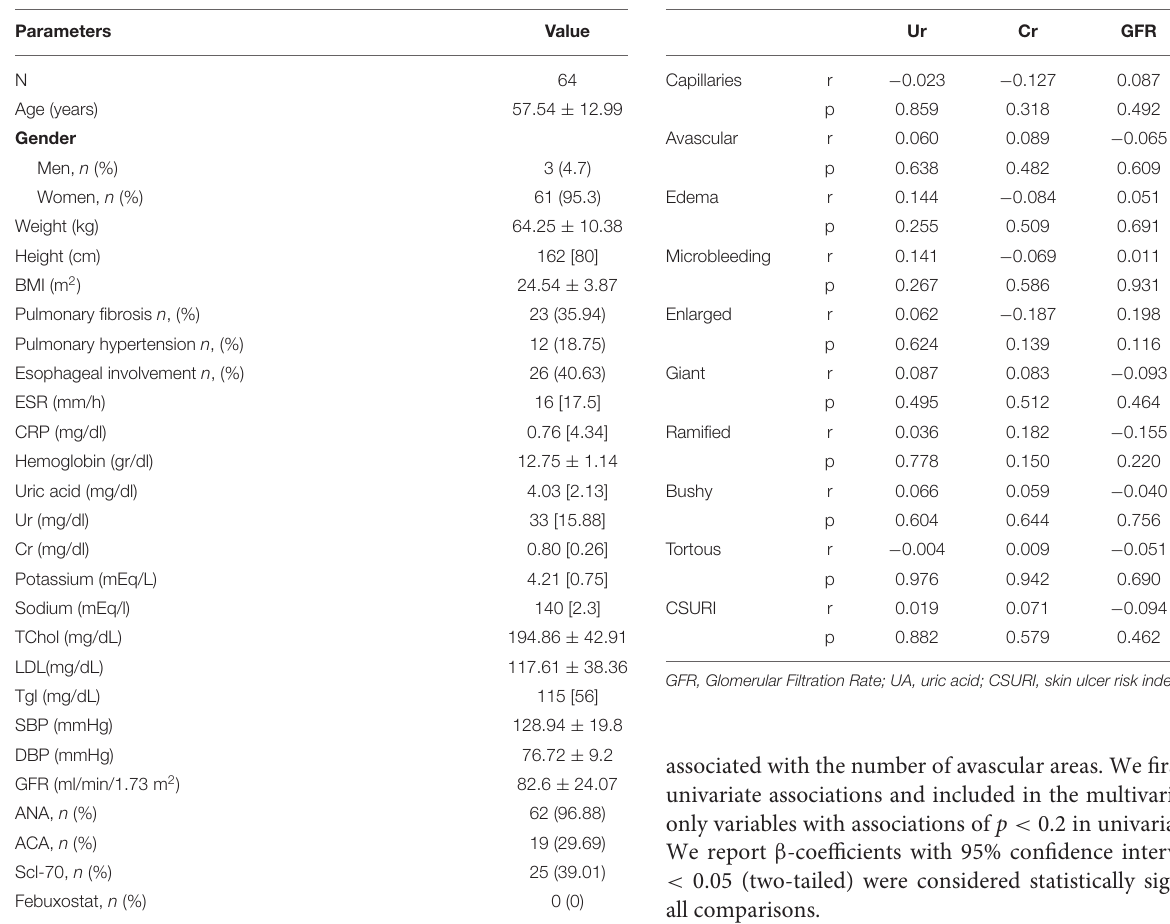
TABLE 1 | Baseline characteristics of the study participants. TABLE 2 | Correlation of urea, creatinine, GFR, and UR with NVC